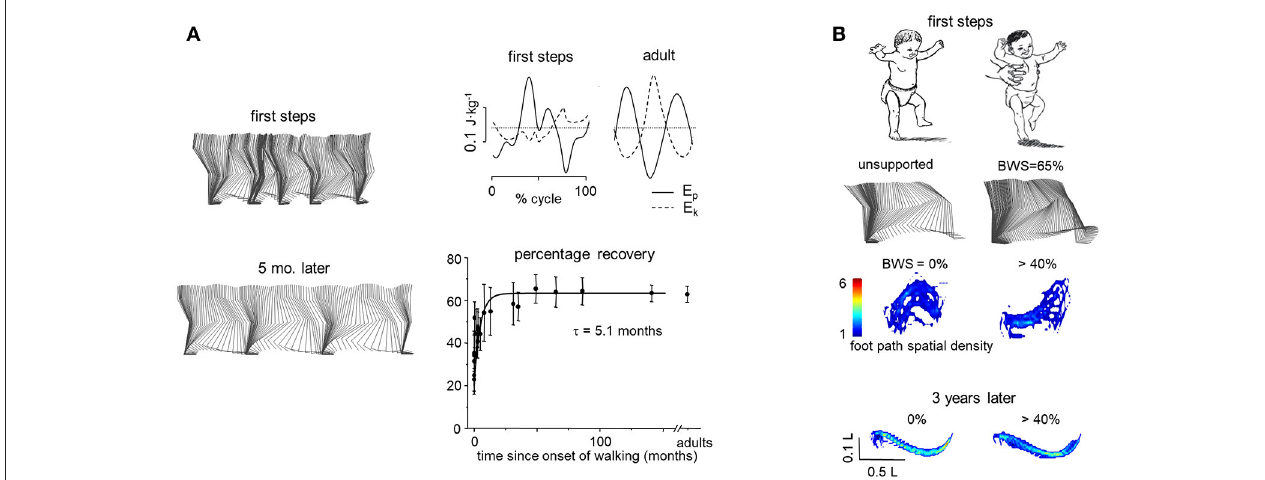
FIGURE 2 | Developmental considerations. (A) examples of stick diagrams in the same child during first independent steps (12.5 mo) and 5 months later (left), changes of gravitational potential (E p ) and kinetic energy (E k ) of COM during a single stride in one toddler and one adult (top), and percentage of recovery of mechanical energy of COM as a function of the time after the onset of independent walking fitted by an exponential function (bottom) (adapted from Ivanenko et al., 2004a). (B) stick diagrams of 1 cycle and foot trajectory spatial density plots when the toddler walked unsupported (left) and unloaded (right). Spatial density of foot path was integrated over swing phase (across 10–15 steps) and depicted graphically by means of a color scale (adapted from Dominici et al., 2007): the lower the density (toward blue in color-cued scale), the greater the variability. Plots are anisotropic, vertical scale being expanded relative to horizontal scale. Bottom plots—the same child recorded 3 years later. Note a characteristic (one peak) foot path during normal walking in the toddler and changes in the shape of the foot trajectory when the child was